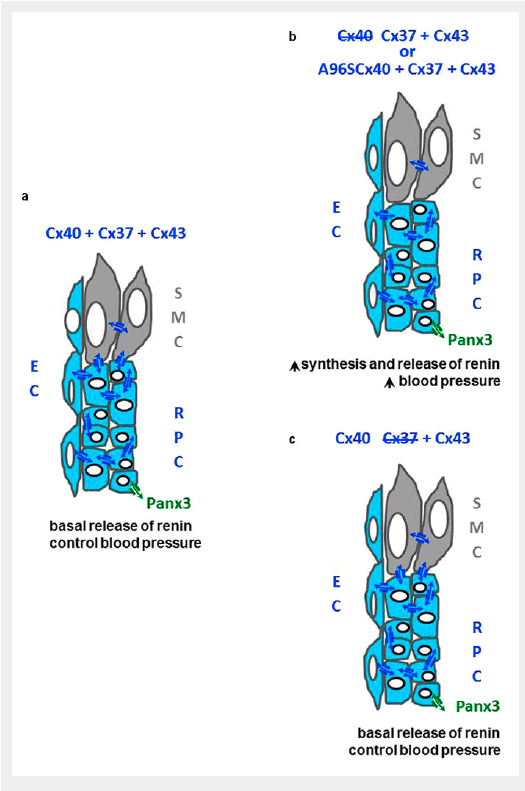
Figure 3 Cx40, Cx37, Cx43 and the renin-producing cells. (a) Within the renal cortex, renin-producing cells (RPC) are coupled by Cx37 and Cx40 channels, to companion cells and nearby endothelial cells (EC), and also express Panx3. The smooth muscle cells (SMC, grey) of the afferent arterioles are coupled by Cx43 channels to companion cells and to RPC. (b ) Loss of Cx40 increases the major function of RPC, i.e. renin biosynthesis and secretion, resulting in persistent hypertension. These changes are also observed when cells express the A96S variant of Cx40 ( b ), but not after deletion of Cx37 ( c ). The alterations in renin secretion observed under such conditions mimic those observed in most forms of